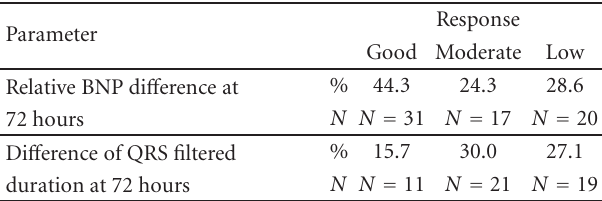
Table 2: BNP and QRS filtered duration variations after 72 hours.